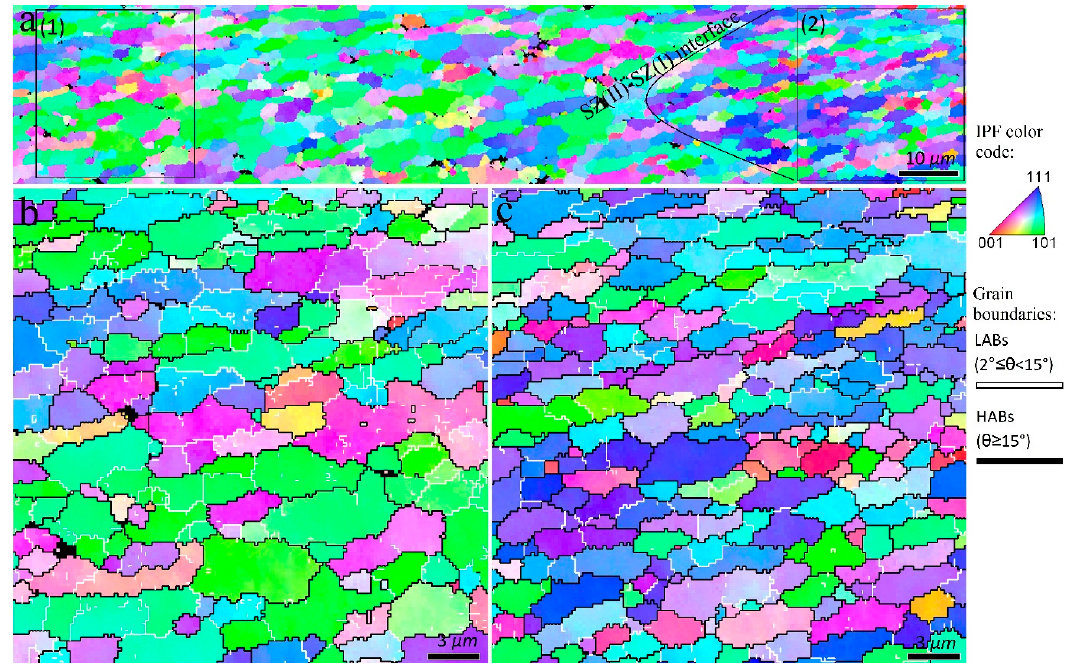
Figure 12. Inverse pole figure maps of the interfacial area between SZ-I and SZ-II in the 3-pass sample indicated by rectangle 2 in Figure 10). Higher magnification of zones 1 and 2 indicated in ( a ) are illustrated in ( b ) and ( c ), respectively.